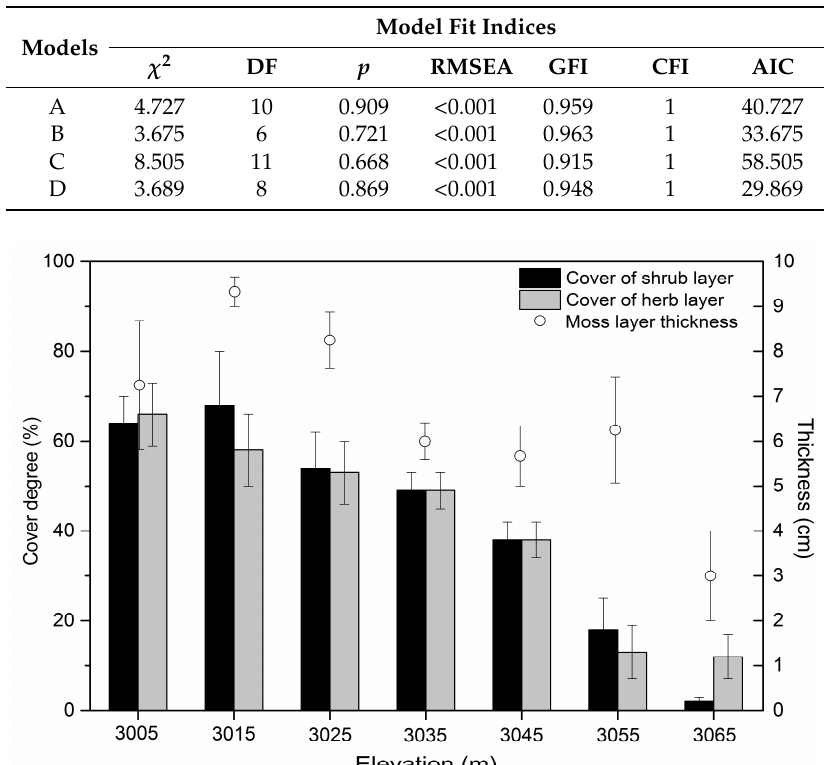
Table 3. Values of the fit indices of four structural equation models for Abies faxoniana regeneration in a subalpine coniferous forest. For information associated with Models A, B, C, and D see Figure 5. DF, RMSEA, GFI and CFI represent degree of freedom, root mean square error of approximation, goodness fit index and comparative fit index, respectively.